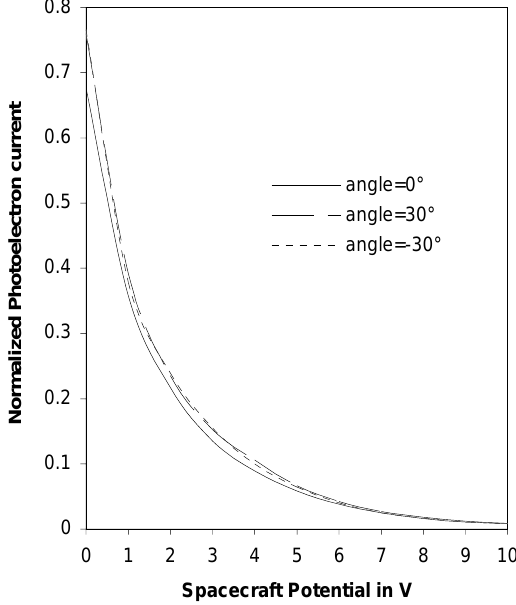
Fig. 6. Photoelectron current-voltage characteristics for B 0 = 0 (circles), B 0 = 1 µ T (squares) and B 0 = 5 µ T (triangles). The dashed and dash-dot curves display the currents ejected from a point source and from a planar surface, respectively. All the curves are normalized with respect to the photoelectron saturation current.